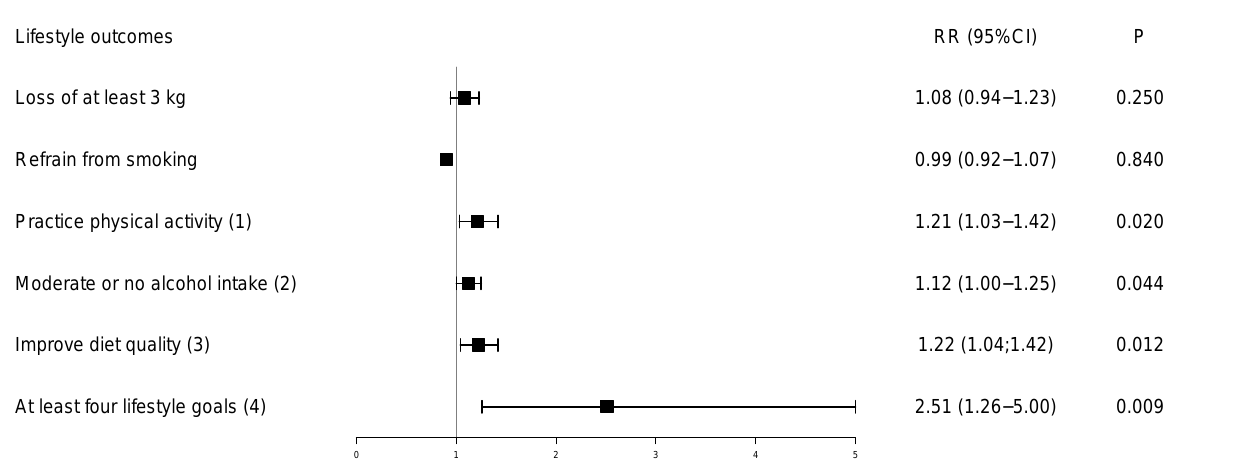
Figure 2. Relative risk of lifestyle goals at the end of the trial adjusted for baseline values. The control group is the reference. (1) Physical activity ≥ 150 min/week; (2) Moderate or no al- cohol intake: 100 g (women)/200 g (men)/week; (3) Following two of six dietary recommen- dations (fruits and vegetables ≥ 21 servings/week; whole grains ≥ 14 servings/week; low-fat dairy ≥ 7 servings/week; sodium-rich foods ≤ 1 serving/week; fast or fried food < 1 serving/week; fried or fatty meats < 1 serving/week); (4) Achieving four out of five lifestyle goals in the follow-up; RR = relative